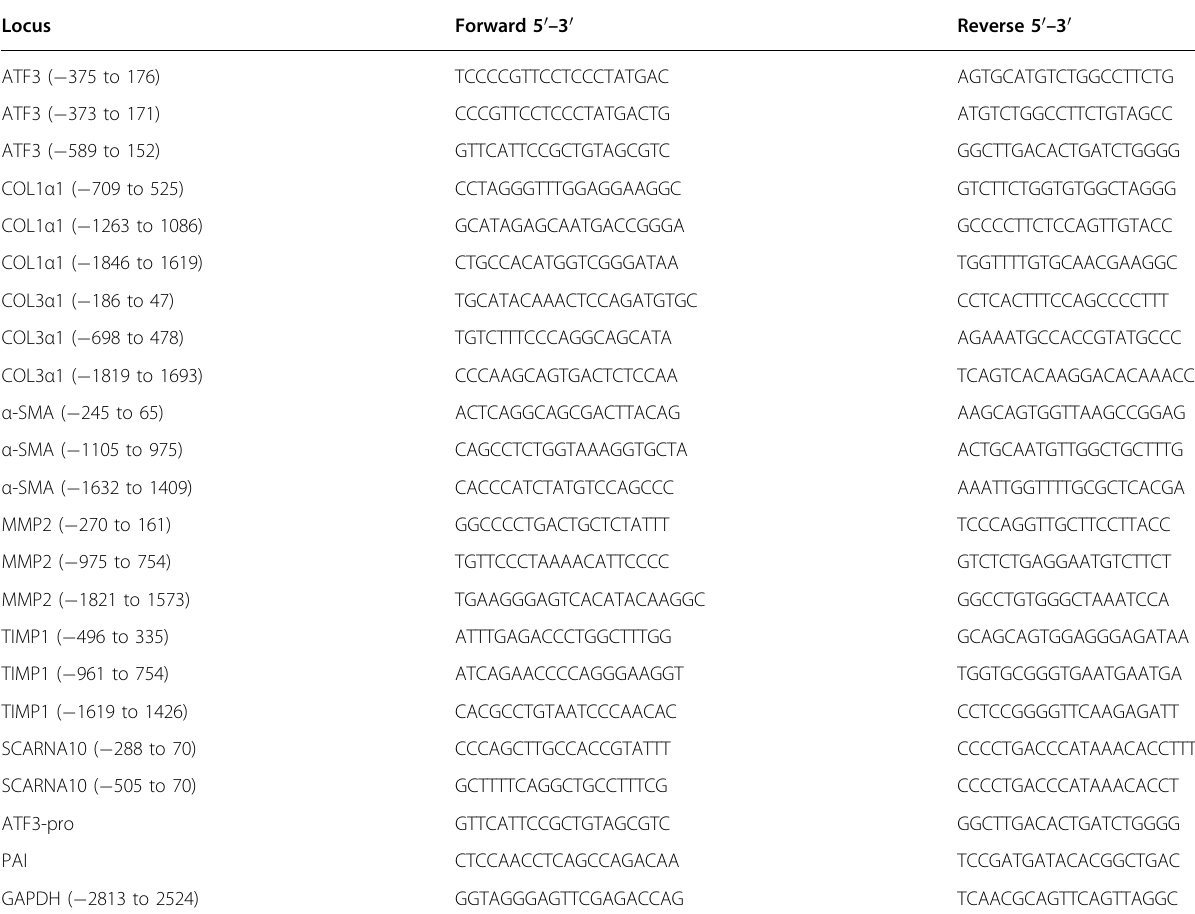
Table 2 Primers for human ChIP qRT-PCR.